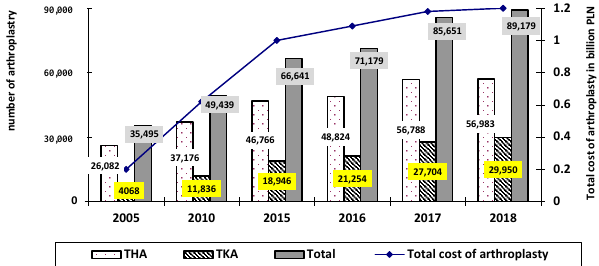
Figure 5. The number and costs of joint replacement surgeries performed in 2005–2018 (author’s own study based on [8–14]). In conclusion, the number and costs of joint replacement surgeries performed in 2005–2018 in Poland were growing dynamically, especially for the knee joint. The worldwide escalation of knee joint